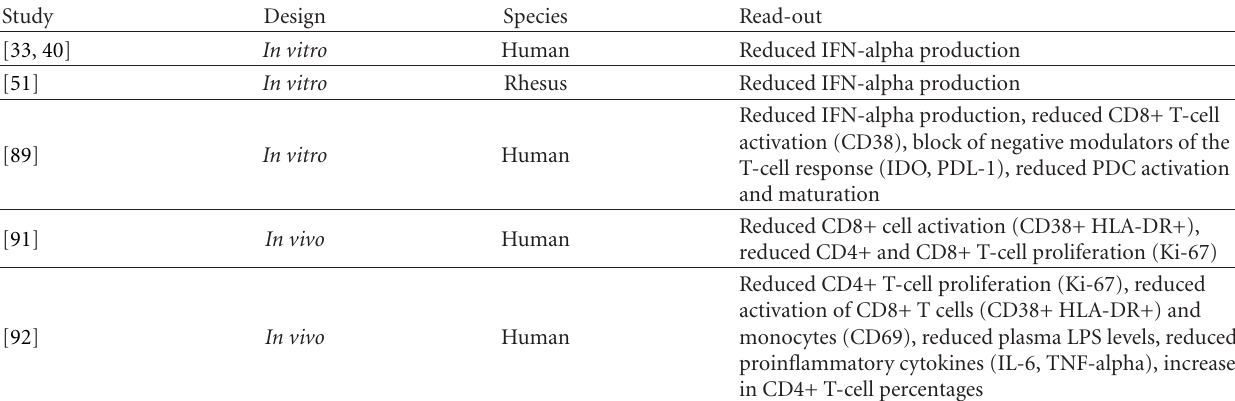
Figure 1: Proposed model of the type I interferon induction by HIV-1 and HIV-1-infected cells. Attachment to the CD4 receptor of plasmacytoid dendritic cells (PDC) triggers the HIV-1 uptake into an endosomal compartment. Subsequent acidification releases nucleic acids from lysed virions, preferentially recruits Toll-like receptor (TLR) 7, and activates the MyD88-dependent pathway. Translocation of the interferon response factor (IRF) 7 into the nucleus activates production of type I interferons (IFN). HIV-1 can also infect PDC via interaction with CD4 and the coreceptors. So far, it is unclear whether virions can escape from the endosomal compartment and initiate productive infection. Another pathway of type I interferon production was recently described in the absence of endosomal TLRs, namely, the recognition of HIV-1 RNA via cytosolic pattern recognition receptors (PRR) and IRF3 [39]. The role of this pathway for the IFN-alpha induction in PDC needs to be further elucidated. Table 1: E ff ect of chloroquine on the HIV-1 and SIV-induced type I interferon production and/or subsequent immune activation in vitro and in vivo